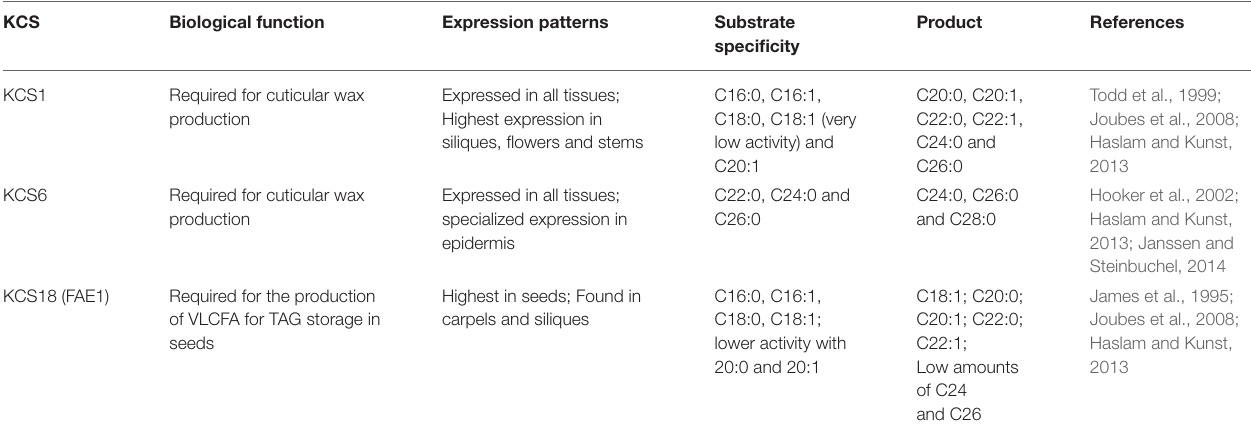
TABLE 1 | Properties of A. thaliana ketoacyl-CoA synthases used in this